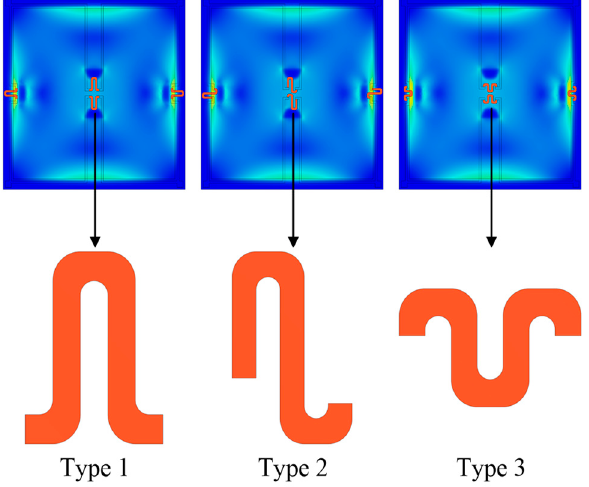
Figure 12. Three different serpentine-shaped